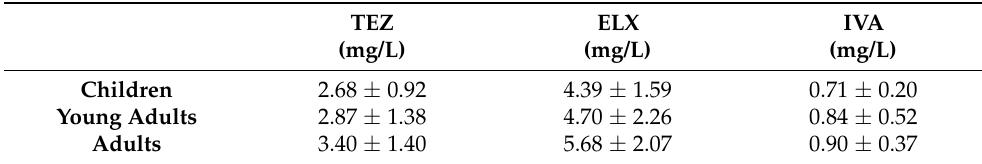
Table 3. TEZ, ELX, and IVA plasma levels (mg/L) expressed as mean ± SD in children, young adults, and